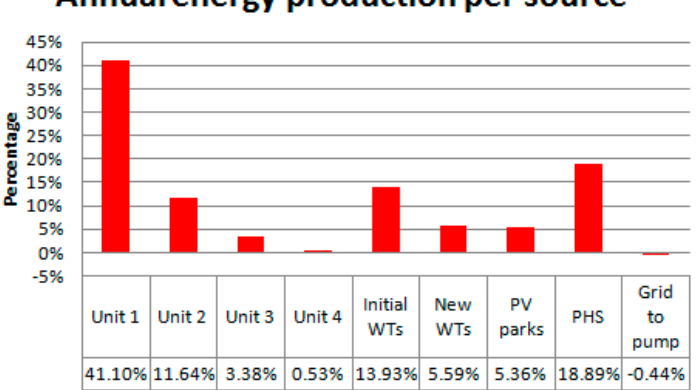
Figure 11. Annual energy production in Samos Island from di ff erent sources, considering hybrid power station operation ( P hydro = 7.0